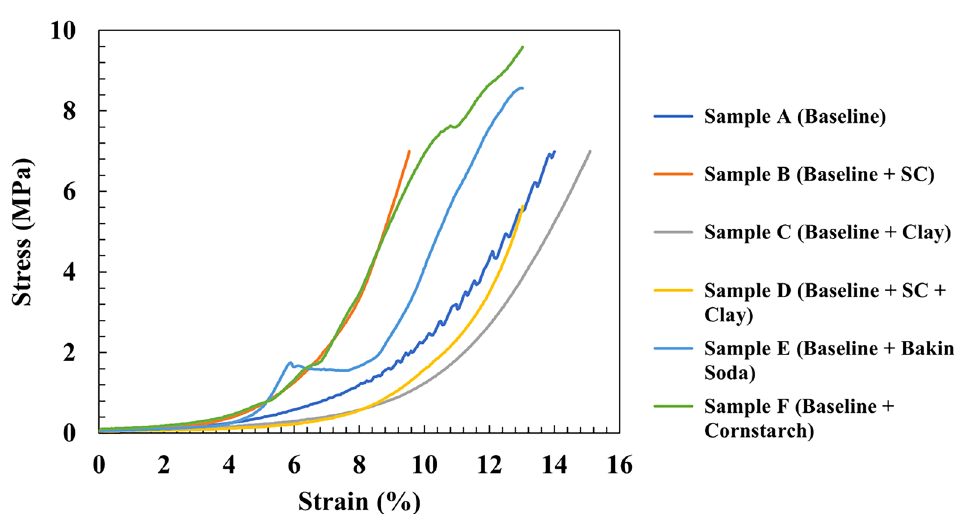
Figure 6. Stress–strain curves of samples A–F.